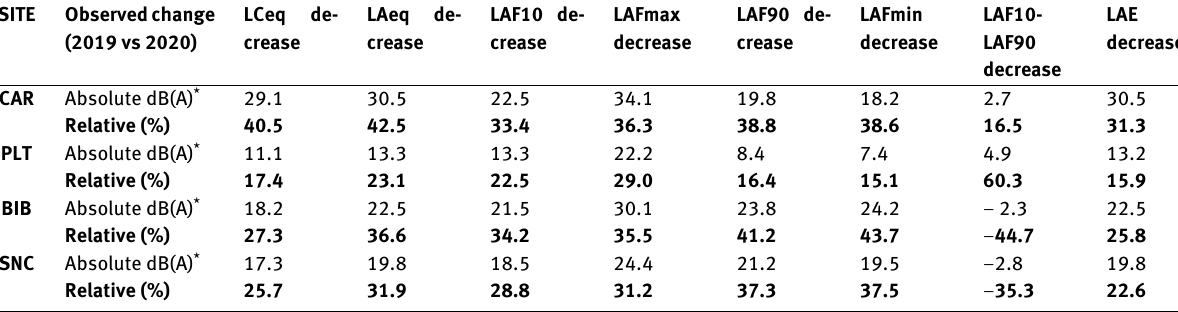
Table 5: Absolute and relative changes in sound levels before (2019) and during lockdown (2020); (*) LCeq dB(C) SITE